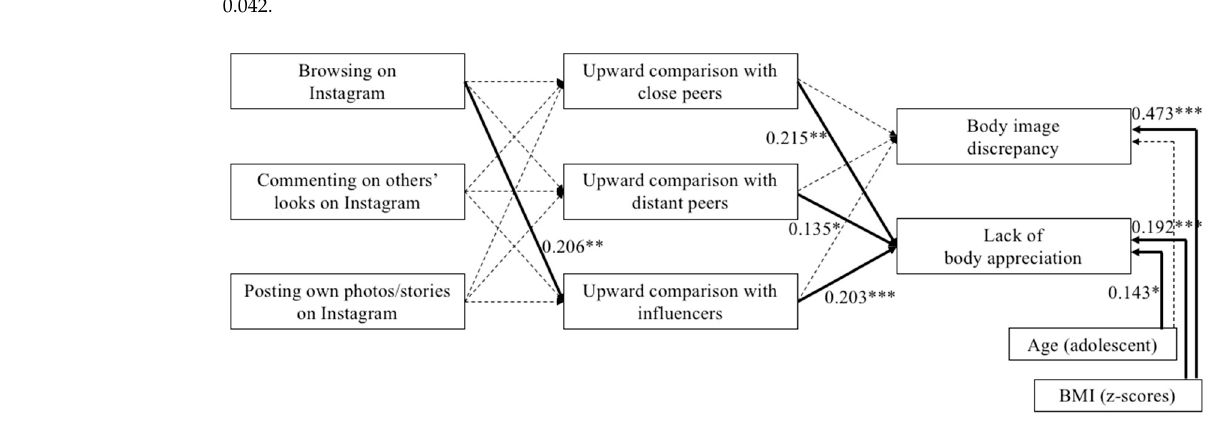
Figure 2. Final mediation model, * p < 0.05; ** p < 0.01; *** p < 0.001. Only significant standardized path coefficients for continuous variables are displayed. Dotted lines display non-significant paths.